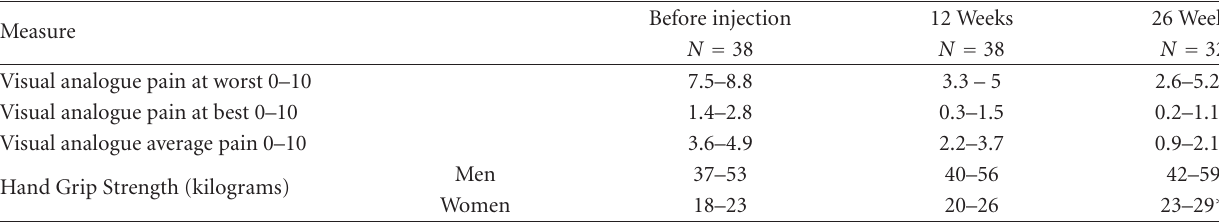
Table 2: Shows the 95% CI for pain, grip, and the patient-rated tennis elbow Evaluations of the 38 patients before injection, 12 weeks after injection, 26 weeks and one to four years after